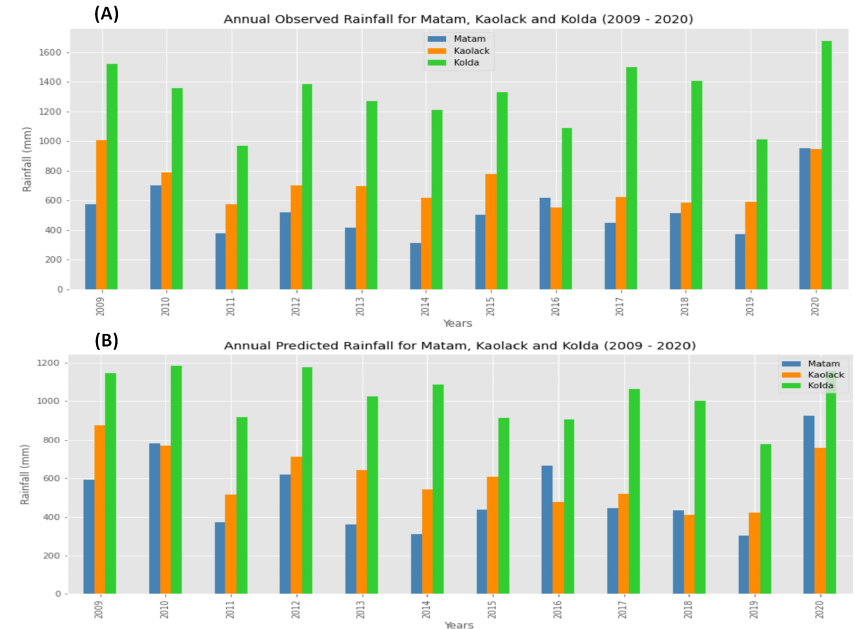
Figure 23. Observed and Forecasted Rainfall for Matam, Kaolack and Kolda